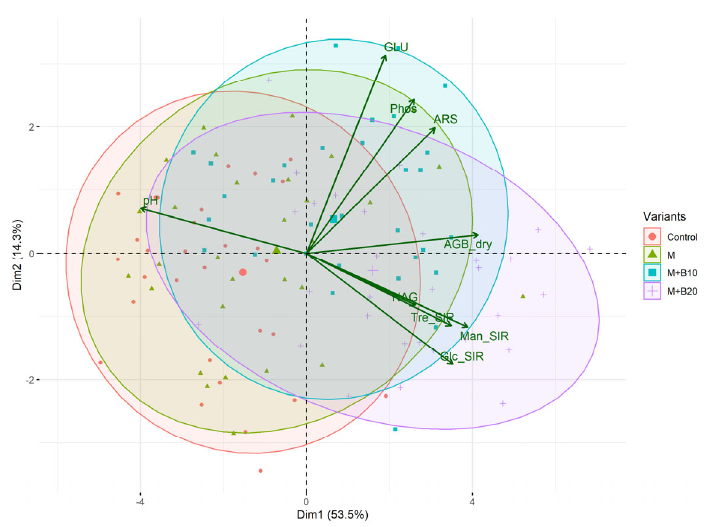
Figure A1. PCA biplot analysis of properties determined in the experiment.